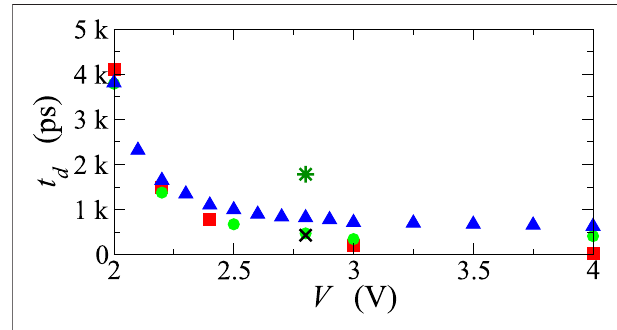
FIGURE 8 | Simulated delay time t d as a function of the amplitude of the applied signal V .Theredsquaresandthegreencirclesrefertothecasewhere theinputsignalisapplieddirectlytothePCMandconsistsofavoltagestepor, respectively, of a trapezoidal voltage pulse like those of Figure 5 (in the latter case the amplitude of V is given by the plateau value). The blue triangles refer to the case where the input signal (still a trapezoidal pulse) is applied through the circuit of Figure 1 , with R L = R S = 1 Ω and C = 300 pF. The cross (star) shows the delay time for V = 2.8 V when the value of the capacitance is changed to 30 pF or 1,000 pF,